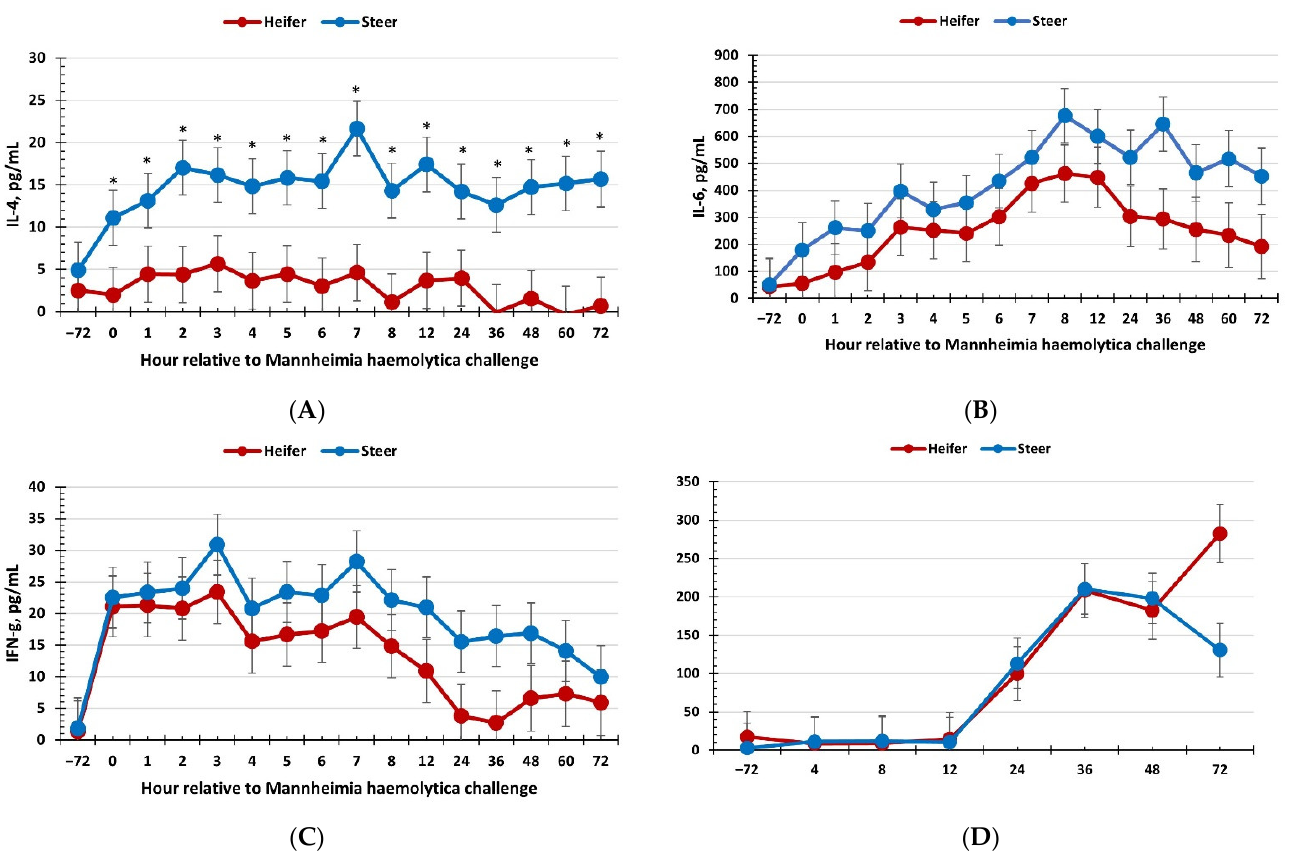
Figure 3. Influence of calf sex on the ( A ) interleukin-4 (IL-4); ( B ) interleukin-6 (IL-6); ( C ) interferon- γ; and ( D ) haptoglobin response to a dual viral–(bovine herpesvirus-1; 1 × 10 8 pfu/nostril) bacterial ( Mannheimia haemolytica ; 1.3 × 10 7 cfu) respiratory disease challenge. ( A ) There was a sex × time interaction ( p = 0.02) for concentrations of IL-4 where they were lower in heifers than steers at 0 h and from 2 to 72 h post-MH challenge. ( B ) There was a tendency ( p = 0.10) for IL-6 concentrations to be reduced in heifers compared to steers. * Sexes differ p ≤ 0.05.